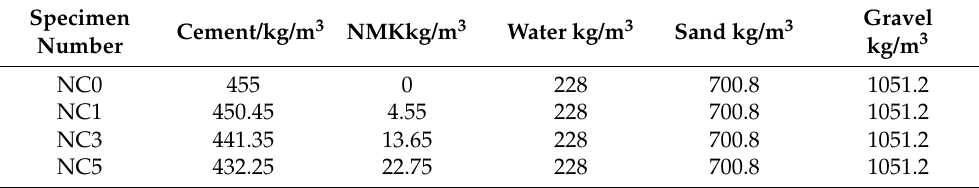
Table 4. Mix proportion of concrete.